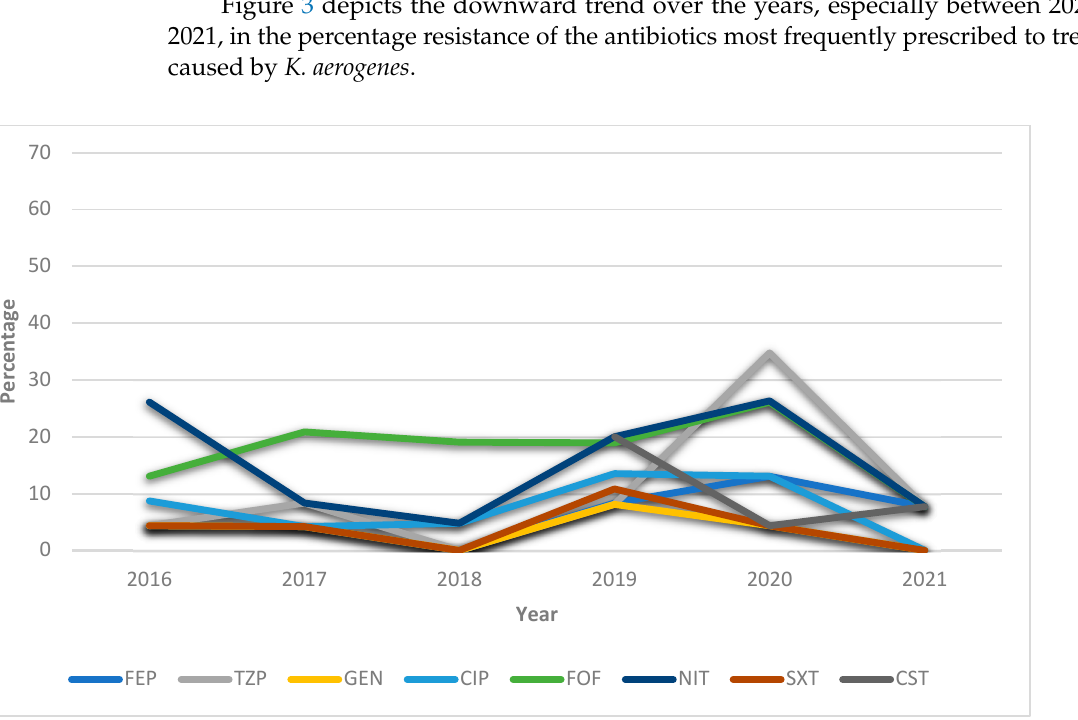
Figure 3. General annualized resistances (%) of Klebsiella aerogenes between 2016 and 2021 against the antibiotics most frequently used to treat UTIs. FEP = cefepime; TZP = piperacillin–tazobactam; GEN: gentamicin CIP = ciprofloxacin; FOF = fosfomycin; NIT = nitrofurantoin; SXT = trimethoprim– sulfamethoxazole; CST = colistin.